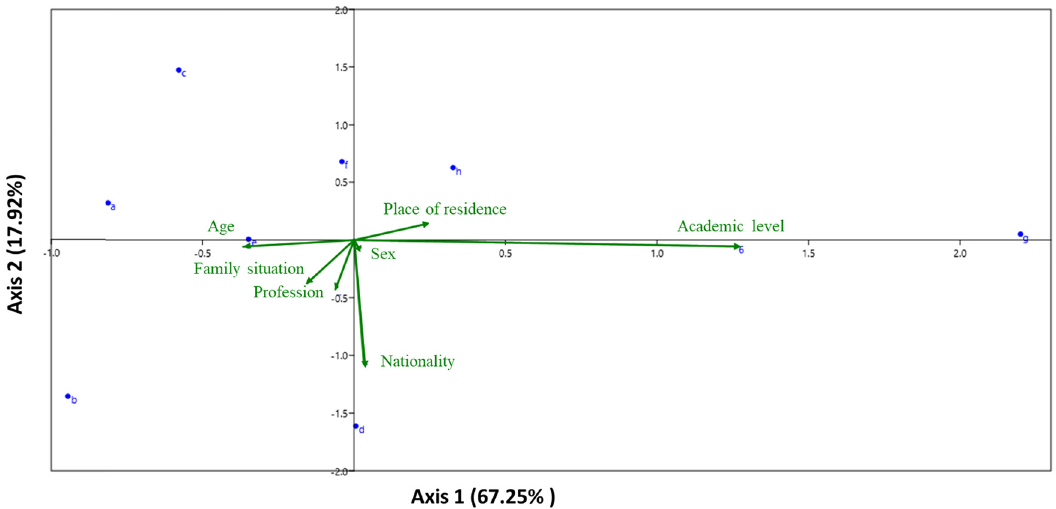
Figure 2: Canonical correspondence analysis ( CCA ) representing the impact of COVID - 19 on the consumption of organic products. ( a ) Have you ever had the COVID - 19 disease? ( b ) Since the COVID - 19 health crisis, has our eating behavior really changed? ( c ) During quarantine, has the number of your daily meals changed? ( d ) In light of the COVID - 19 health crisis, does your consumption of organic products have increased or decreased? ( e ) In your opinion, after quarantine, the demand for natural products ( organic ) will be high or low? ( f ) Do you think that organic food is part of our future? ( g ) How many meals do you eat per day? ( h ) Have you ever heard of organic products?.